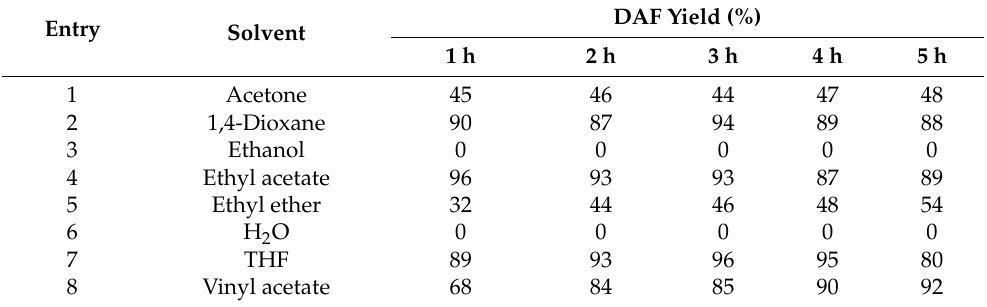
Table 2. Enzymatic transesterification of fructose with various solvents and reaction